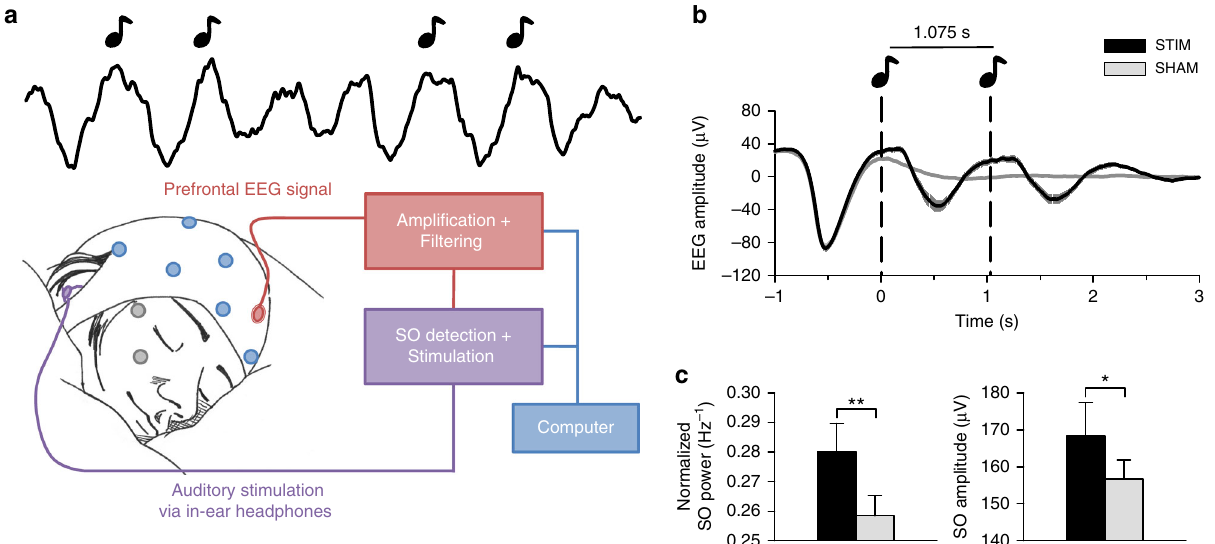
Fig. 1 Auditory stimulation phase locked to endogenous SO peaks boosts SO activity. a Setup: Upon online detection of an endogenous SO in the frontal EEG signal during non-rapid eye movement (NonREM) sleep, two tones (50 ms, pink noise, 50 dB SPL) were delivered via in-ear headphones with an inter- stimulus interval of 1.075 s to coincide with two consecutive SO peaks. In the Sham condition, time points of stimulation were marked, but no stimuli were presented. See “ Methods ” section for further details. Artwork by H.-V.V.N. b Mean ( ± s.e.m.) EEG signal recorded from a frontal (Fz) electrode position during NonREM sleep (S2, S3, and S4) in the 120-min stimulation period, time-locked to the fi rst of the two tones ( t = 0) for the Stimulation (STIM, black) and Sham condition (SHAM, gray). c Mean ( ± s.e.m.) normalized spectral power in the SO peak frequency band (0.8 – 1.1 Hz) and SO amplitude recorded from electrode position Fz and determined for NonREM sleep epochs of the 120-min stimulation period. The average number of NonREM sleep epochs used for this calculation was 158 and 169, respectively, for the Stimulation and the Sham condition. (There was no signi fi cant difference in the number of epochs between conditions, p = 0.123). For normalization, individual spectra were divided by the cumulative power (up to 30 Hz). ** p < 0.01, * p < 0.05, for pairwise comparisons between the Stimulation condition (STIM, black) and the Sham condition (SHAM, gray) with paired t tests, two-sided. n =